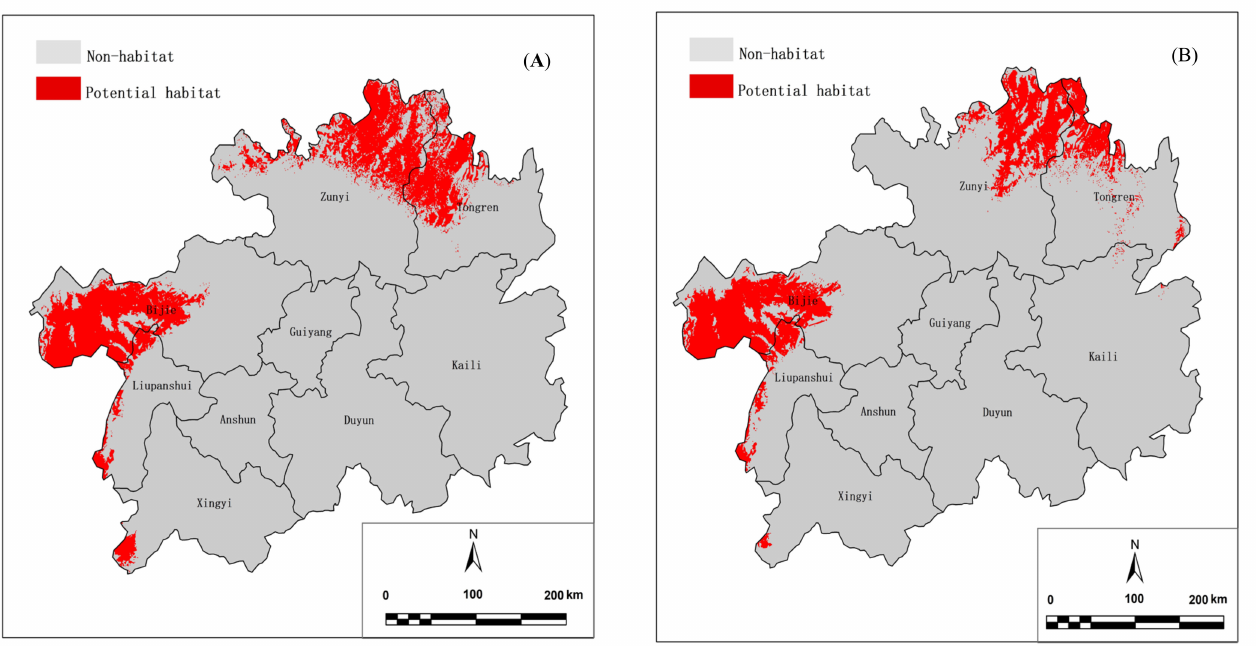
Figure 2. ( A ) Potential habitats under current climate; ( B ) Potential habitats under future climate change scenarios.